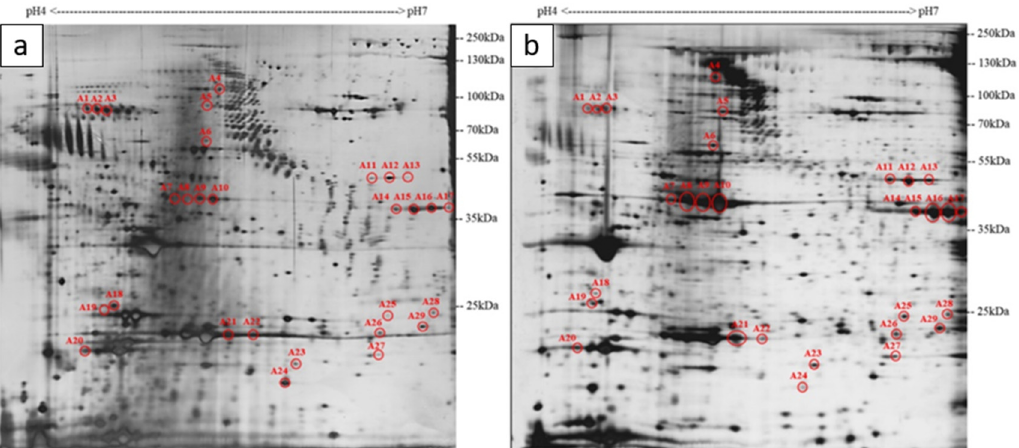
Figure 2. Representative two-dimensional gel electrophoresis (2-DE) images of whole-body proteins extracted from ( a ) K. mikimotoi -exposed medaka with mild-to-moderate symptoms collected at LT 25 , and ( b ) untreated medaka. A protein load of 100 µg was separated by isoelectric focusing with a range of pH 4–7 and sodium dodecyl sulfate–polyacrylamide gel electrophoresis in 10% polyacrylamide gel. Silver staining was used. Spots A1–A29 indicate differentially expressed proteins with at least two-fold differences between the two samples.